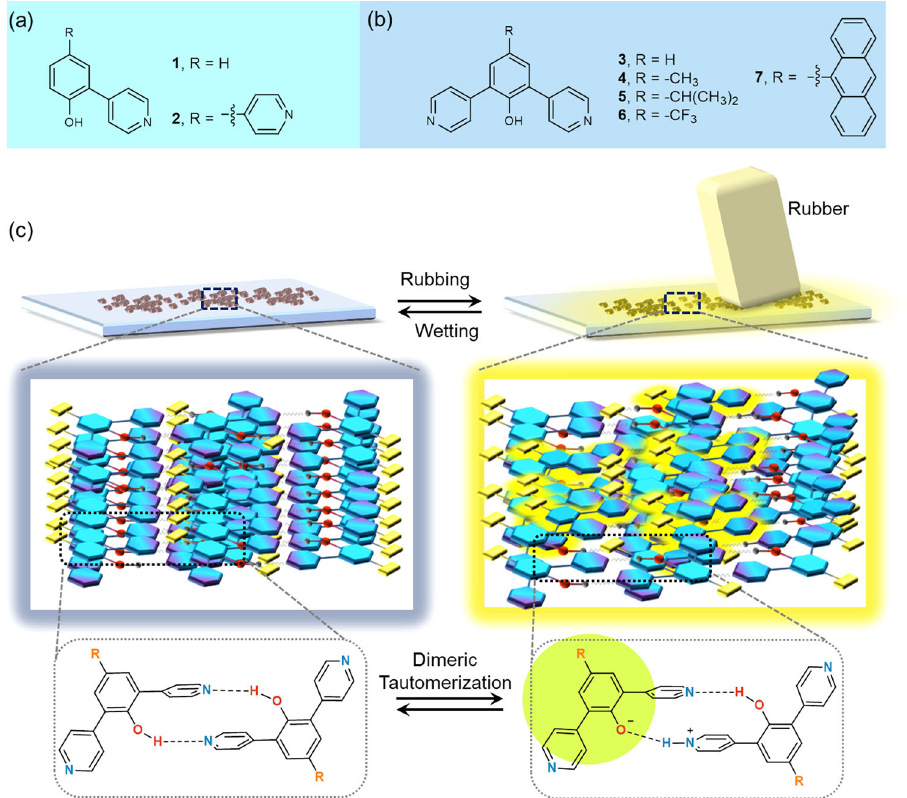
Fig. 1 Research outline. Chemical structure of ( a ) mono-ortho-pyridinil phenols 1 and 2, and ( b ) bis-ortho-pyridinil phenols 3~7. c Illustration of rubbing- induced photoluminescence on the solid sample of bis-ortho-pyridinil phenols in conjunction with a topochemical tautomerization, relying on a negative charge (exactly provided by the triboelectric effect of a rubber)-induced proton transfer process in the double H-bonded dimeric tautomers. The material was simply spread on a frosted glass surface and then was directly abraded with a